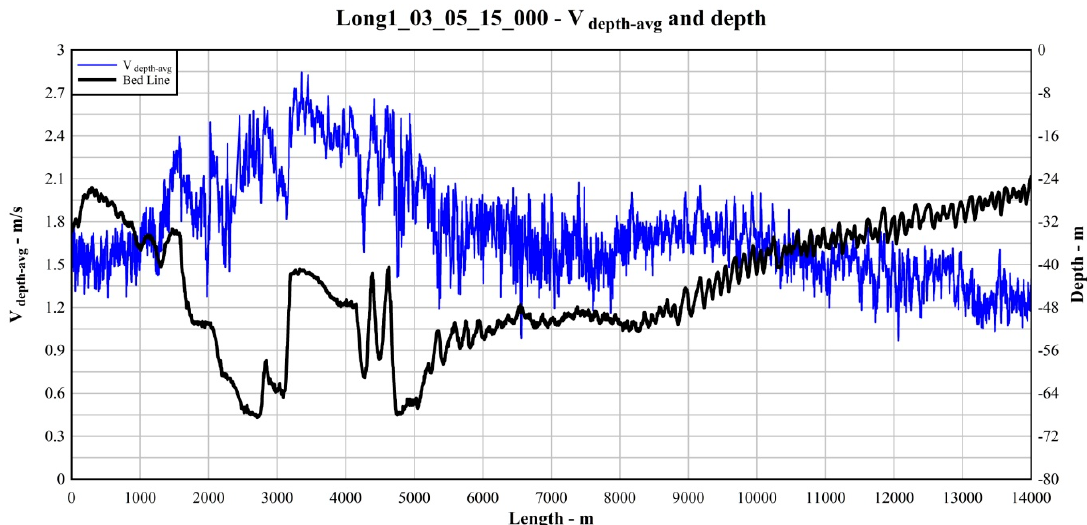
Figure 6. Depth-averaged velocity (blue) and bedline (black) for Long1_03_05_15_000 transect (FS − CNS2).